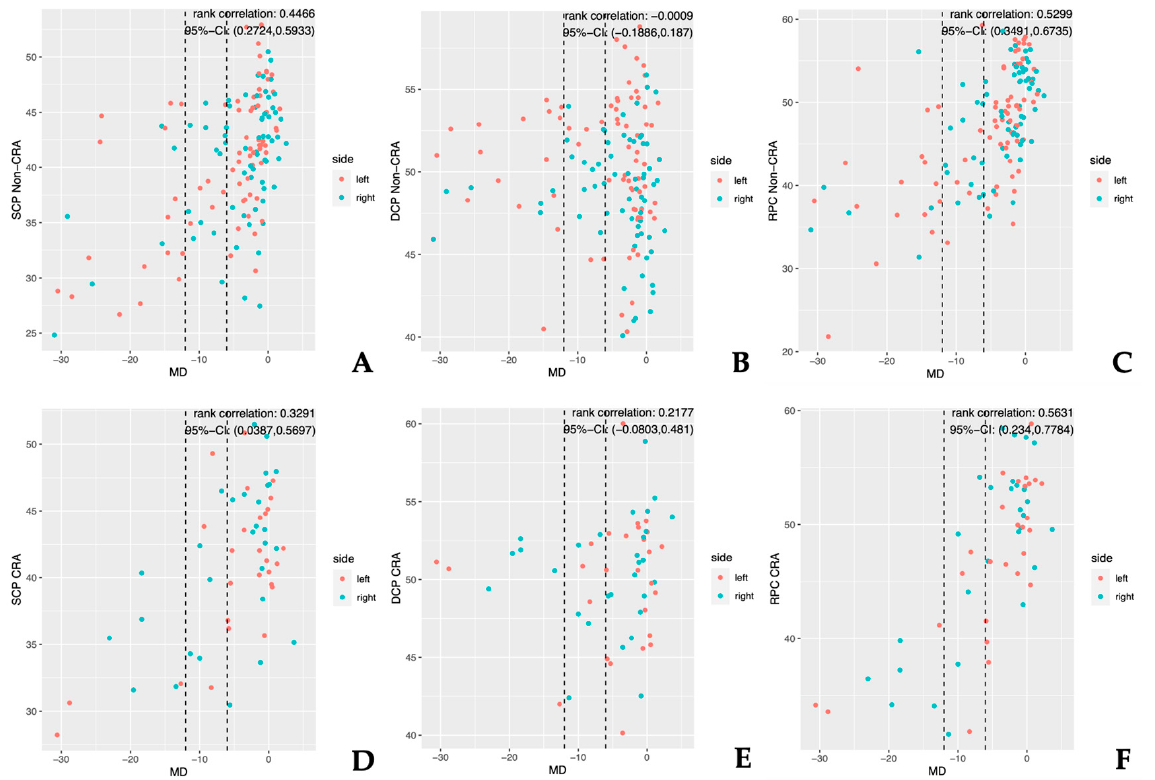
Figure 2. The results of the correlation analysis between the FD values (y-axis) and MD (x-axis) for the entire study population. Glaucoma severity was defined by the MD values. Groups 1 (MD ≥ − 6), 2 (MD < − 6 ≥ − 12), and 3 (MD < − 12) are distinguished by dotted lines. Three sectors, which are representative of the results in their respective locations, are each displayed for the CRA and non-CRA eyes. ( A – C ) Correlation between the superficial ( A ), deep ( B ), and peripapillary ( C ) FD and MD for the non-CRA eyes; ( D – F ) correlation between the superficial ( D ), deep ( E ), and peripapillary ( F ) FD and MD for the CRA eyes. MD = mean deviation; SCP = superficial capillary plexus; DCP = deep capillary plexus; RPC = radial peripapillary capillaries; CRA = cilioretinal artery.